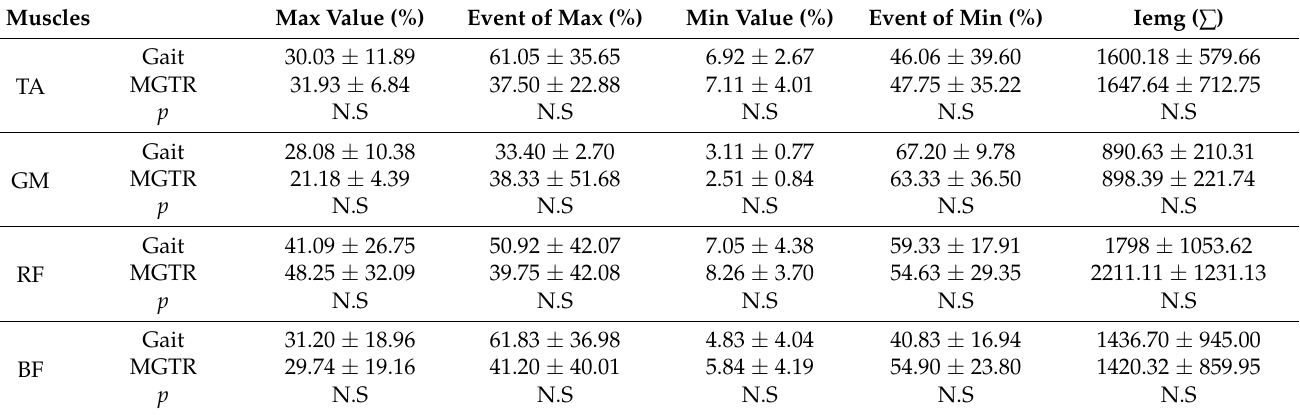
Table 3. Results of the muscle activation